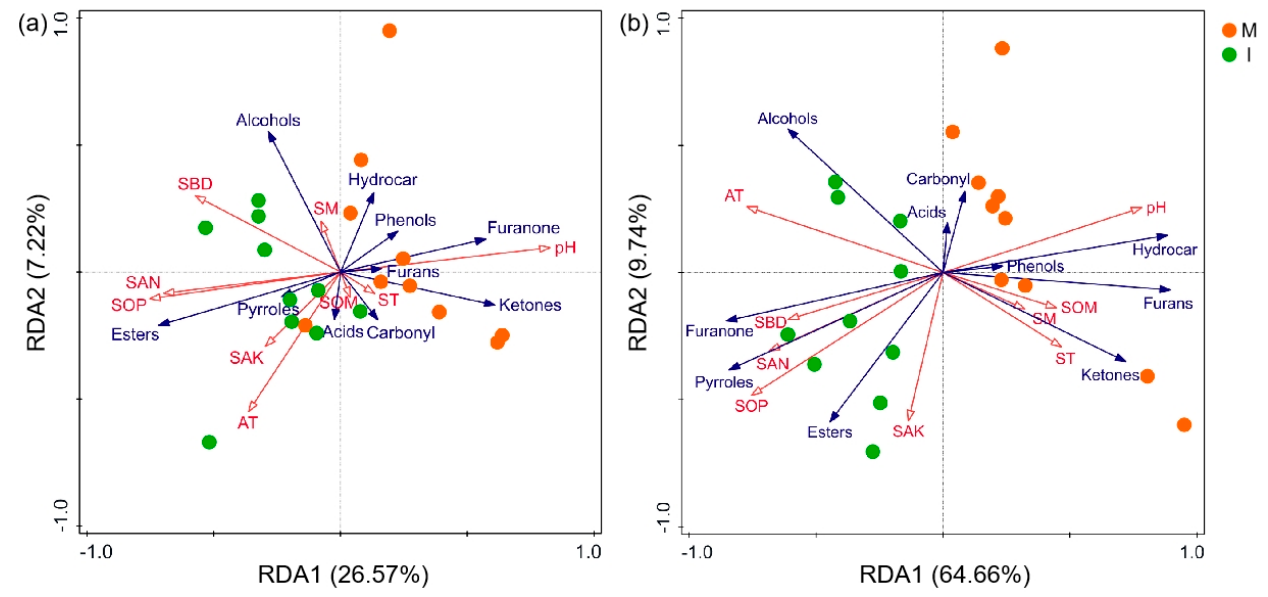
Figure 4. The redundancy analysis (RDA) of the component numbers ( a ) and relative contents ( b ) of volatile substances in different categories and environmental factors under different cultivation patterns. Blue arrows indicate volatile substances, red arrows indicate soil properties. See Figure 1 for treatment abbreviations. Table 3. The results of redundancy analysis (RDA) on the component numbers and relative contents of volatile substances in different categories and soil properties under different cultivation